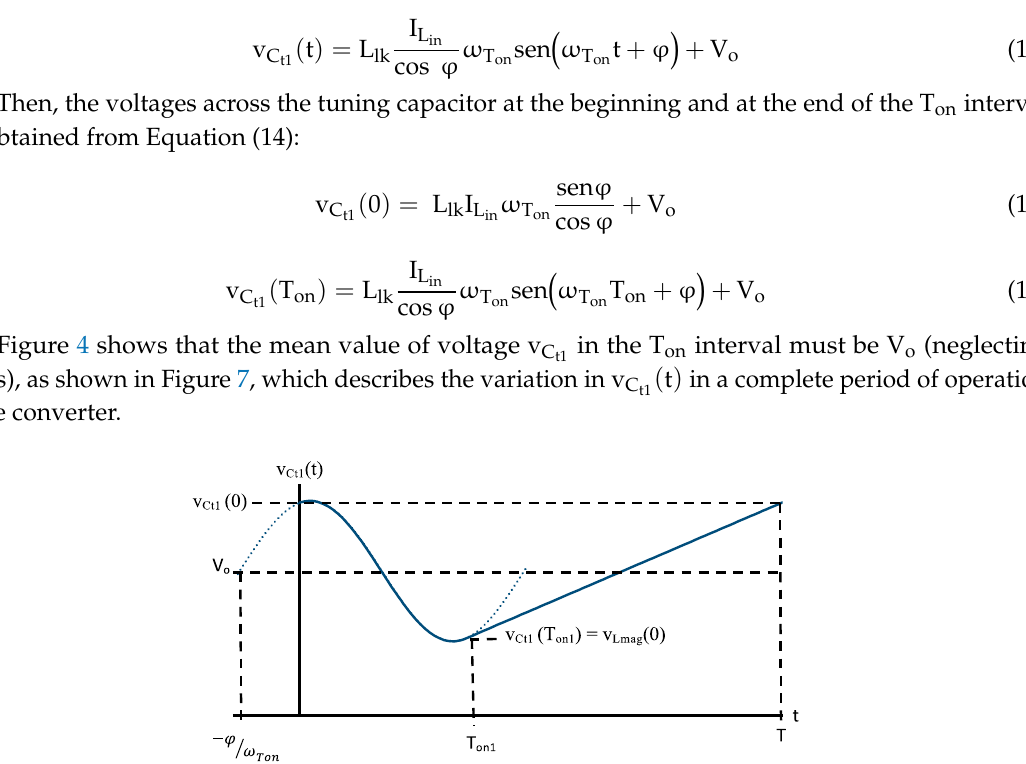
Figure 7. Evolution of the voltage across the tuning capacitor v C